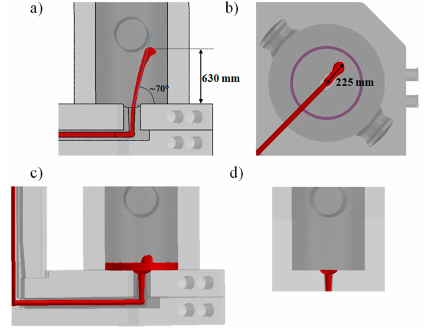
Figure 5. Entrance of steel spout in the case of complete mold with entire running system ( a – c ); and of simplified model ( d ).